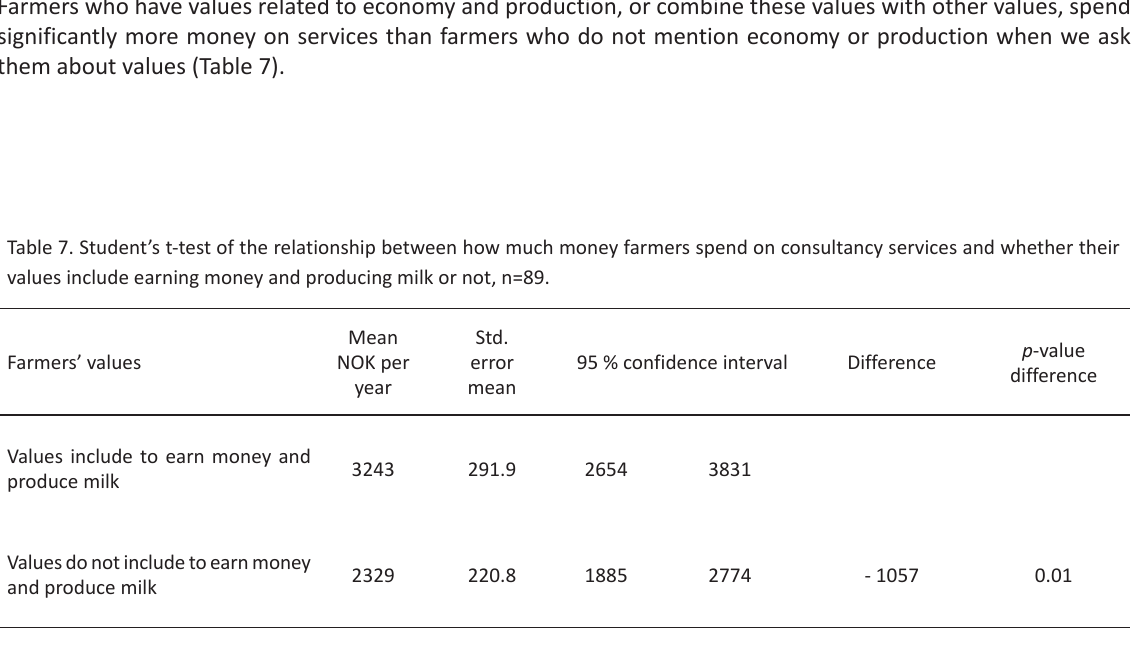
220.8 1885 2774 - 1057